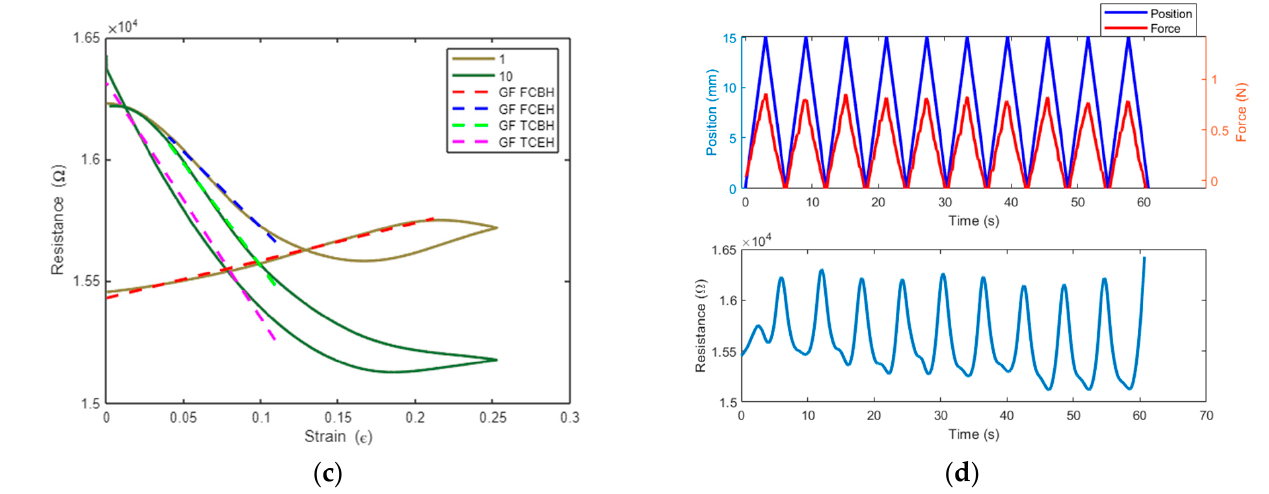
Figure 15. HISS cyclic tensile test results: ( a ) Resistance vs. strain for ten cycles. ( b ) Stress vs. strain for ten cycles. ( c ) Resistance vs. strain and gauge factors for the first and the tenth cycles. ( d ) Displacement, force, and resistance change over time for ten cycles.